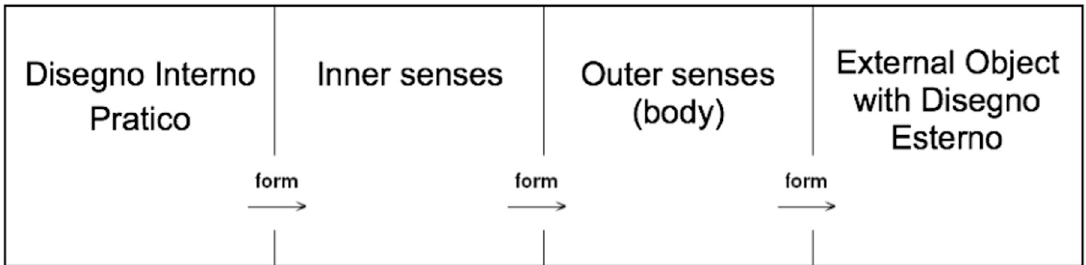
Figure 2: The process of artistic production according to Federico